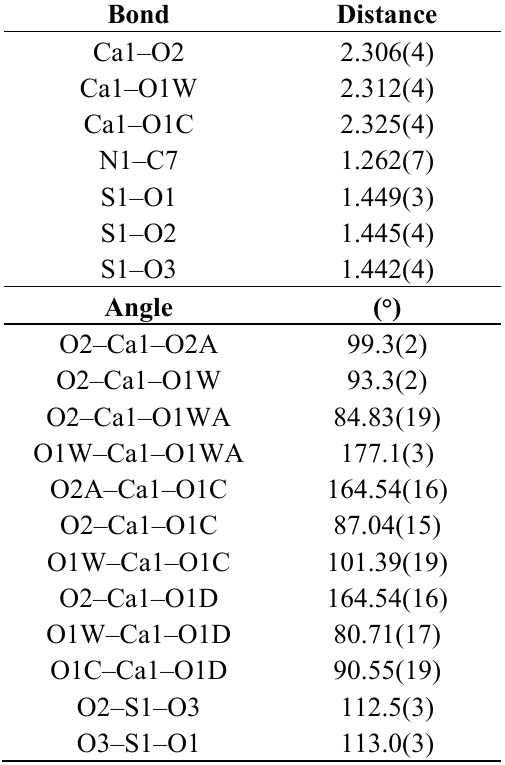
Table 3. Selected bond lengths (Å) and angles (°) for 1